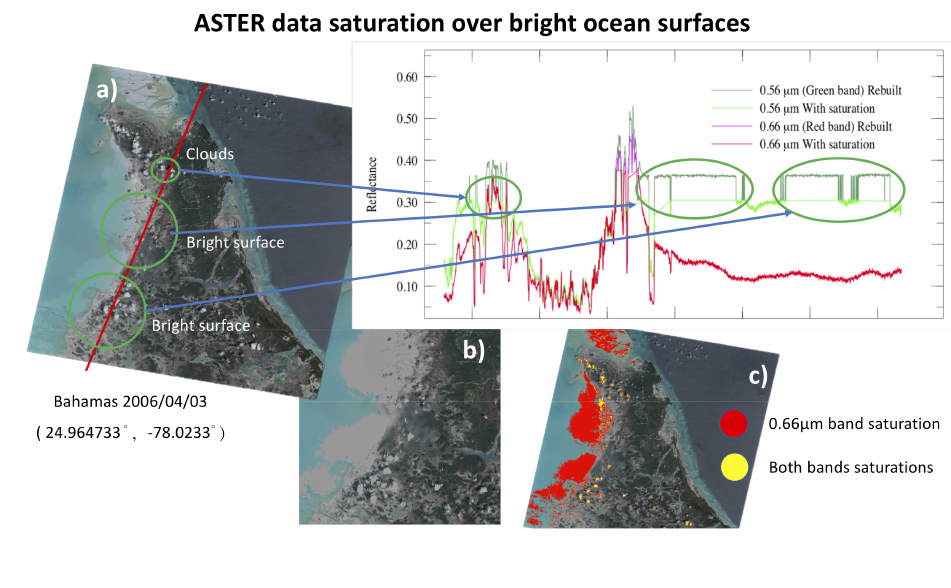
Figure 4. Visualization of the saturation corrections over the ocean: ( a ) final true color composite; ( b ) original saturated granule; ( c ) mask of the saturated areas (in red for the 0.66µm band and in yellow for both 0.56 and 0.66µm bands).